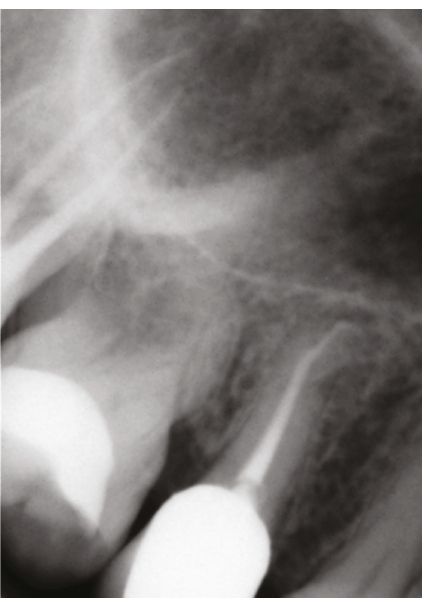
Figure 2: Periapical radiograph showing previous endodontic and prosthetic treatments on upper second premolar.